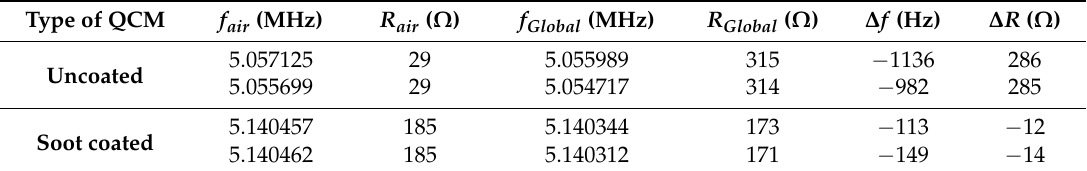
Table 2. Resonance frequency and series resistance values of uncoated and soot coated 5 MHz QCMs in air and after immersion in Global medium containing human